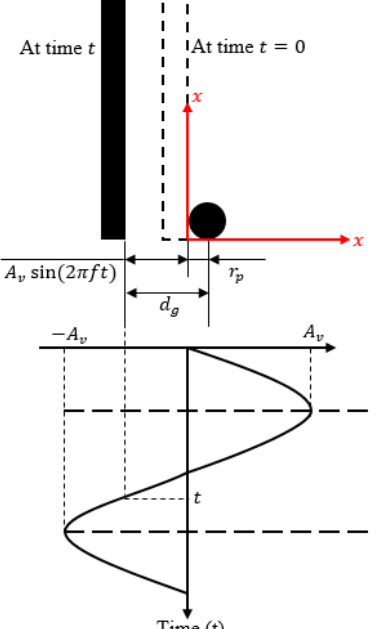
Figure 8 Illustration of the distance between particle center and workpiece